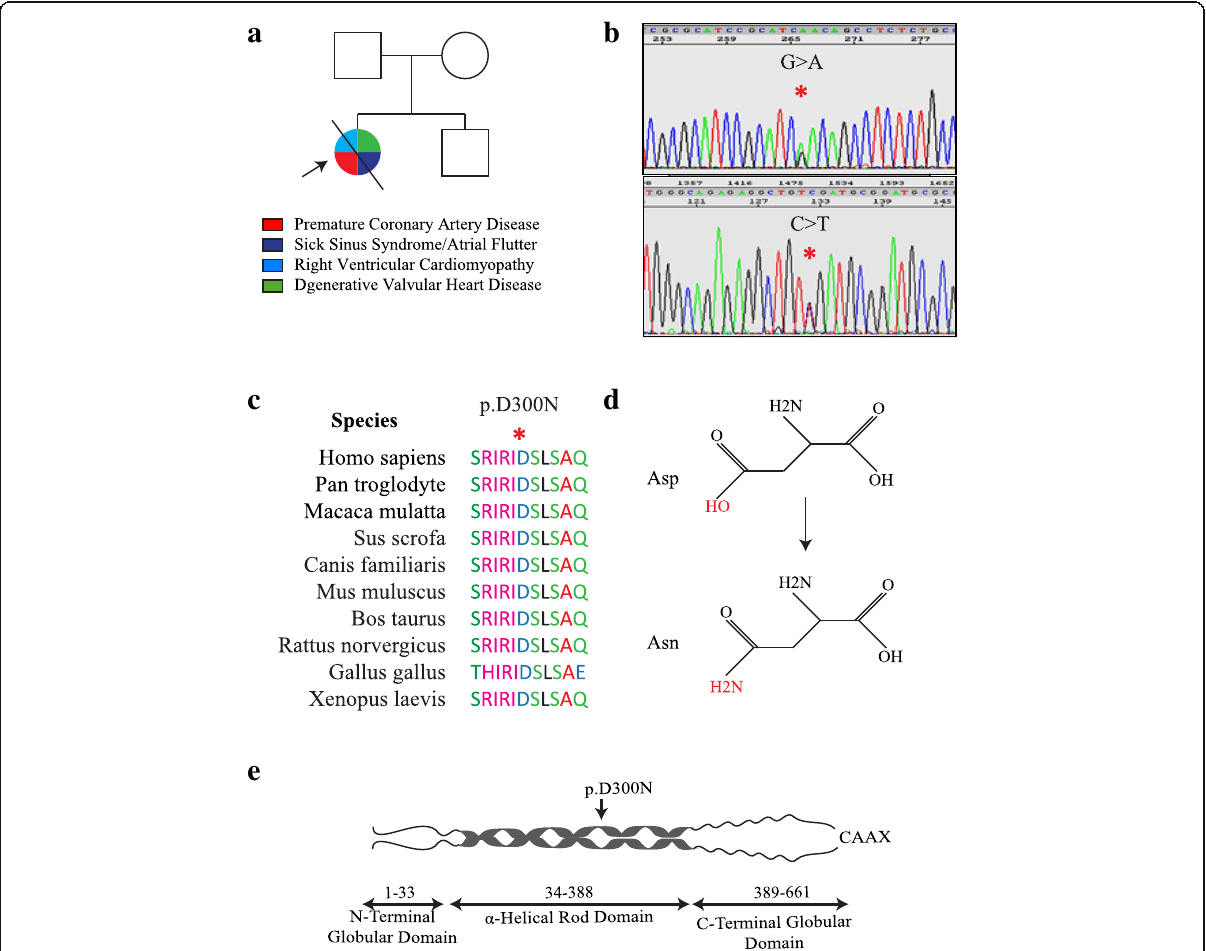
Fig. 1 Identification of p.Asp300Asn Mutation in the LMNA Gene. a Pedigree of the proband containing the phenotypic data. Square box and circle represent male and female members respectively. Full circle indicates an affected member. The / symbol indicates a deceased individual. b Electrophoregrams showing the presence of the mutation in the sense and anti-sense directions. c Evolutionary conservation of the Asp300 amino acid across several species. d The change in the structure of the involved amino acid from a hydroxyl group to an amine group. e Location of the p.Asp300Asn mutation in the LMNA protein, which is the site of LMNA